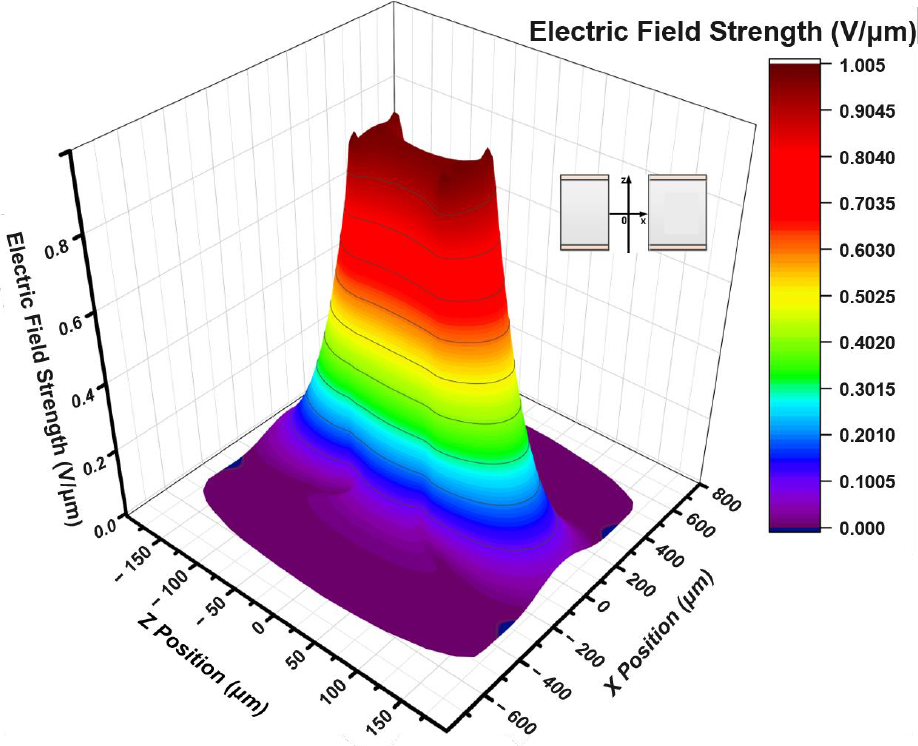
Figure 3. Simulation of electric field strength in a GEM hole.